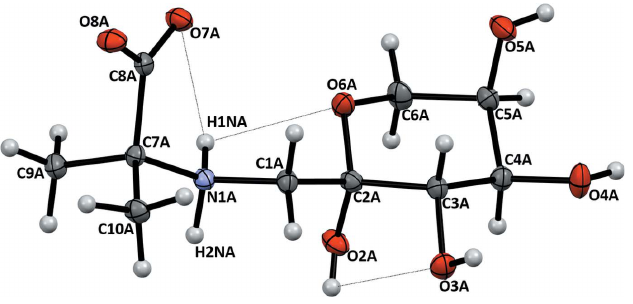
Figure 2 Atomic numbering and displacement ellipsoids at the 50% probability